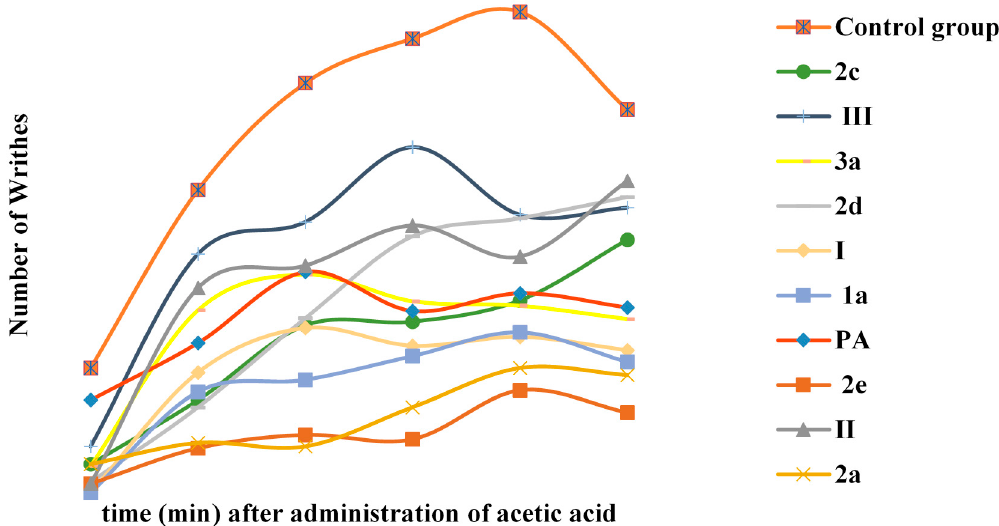
Figure 2. Antinociceptive activity of hybrids 1a , 2a – e , 3a , of the corresponding